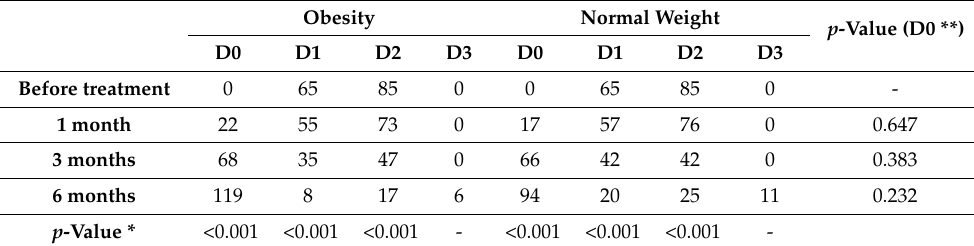
Table 6. Effectiveness of treatment over the examined time